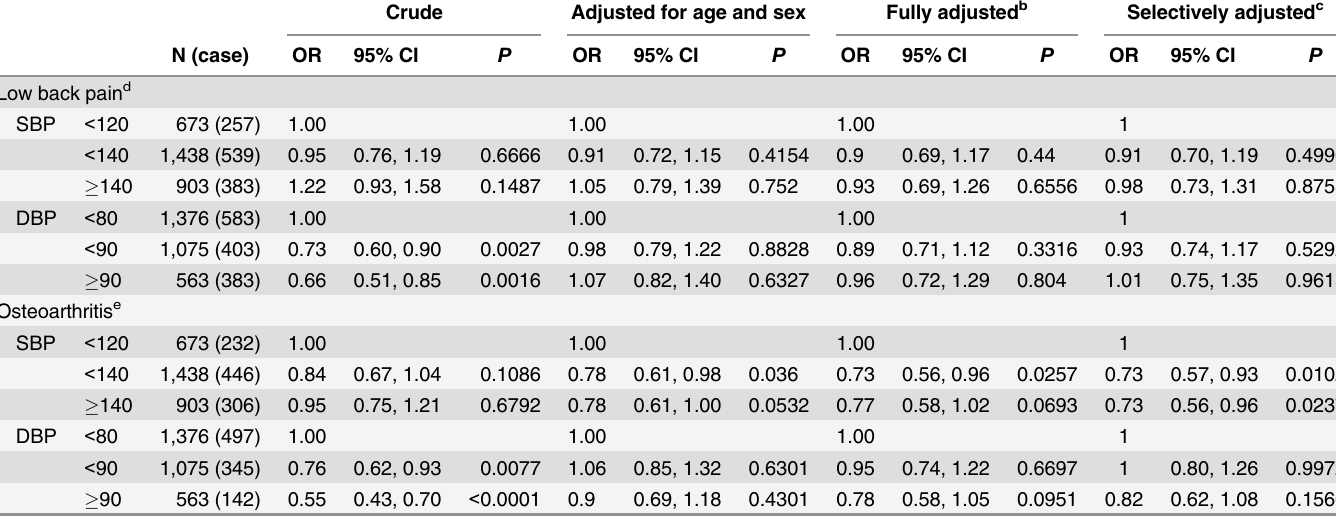
Table 4. Associations Between Systolic and Diastolic Blood Pressure and Low Back Pain or Osteoarthritis in Korean Surveyees of KNHANES IV with Hypertensive Drug Use aged (cid:1) 20 years a . Crude Adjusted for age and sex Fully adjusted